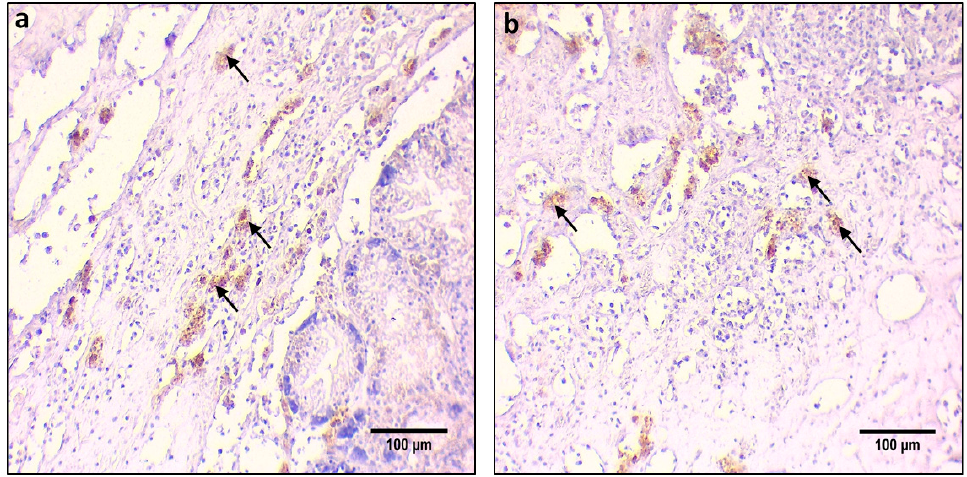
Figure 9. Immunohistochemical detection of the digestive gland tissue showing detected antibodies (arrows) of LC3B in the connective tissue of non-infected ( a ) and infected ( b ) from H. pinnae individuals.